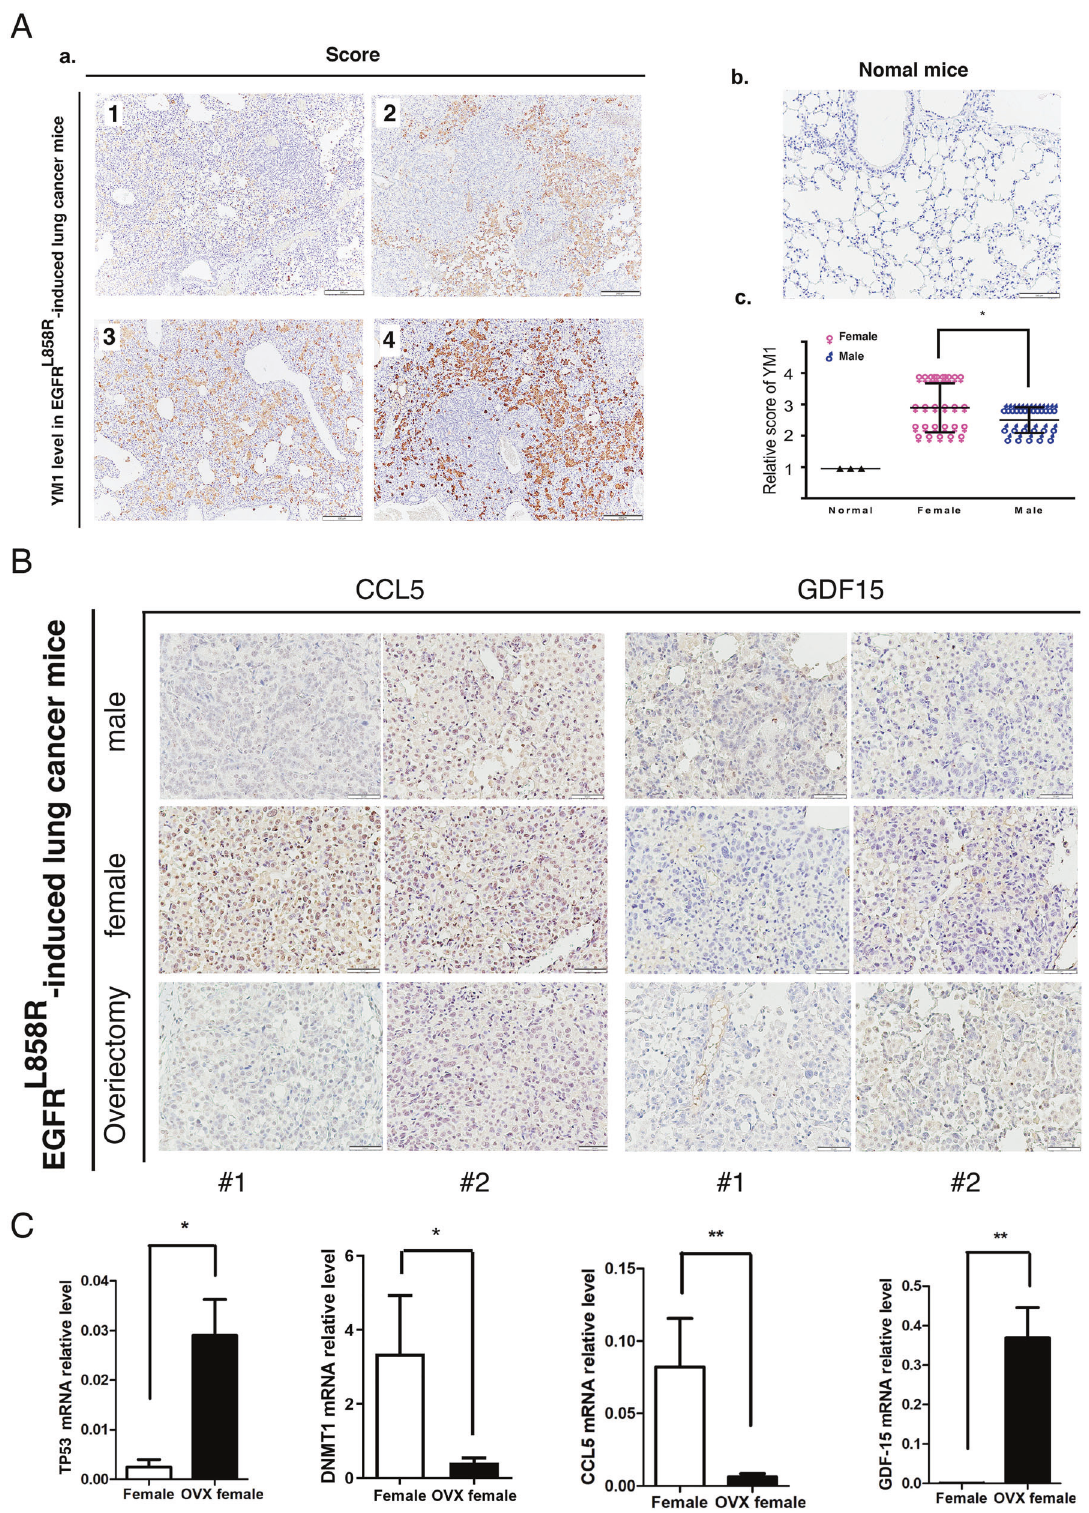
Fig. 7 The relationship among the protein levels of YM1, CCL5, and GDF15 and sex-dependent changes in lung cancer in EGFR L858R mice. The levels of YM1 were determined in EGFR L858R mice, and scored based on the YM1 image (score 1 to 4) ( A , a ) compared to normal mice ( A , b ). All the scores were calculated in normal mice and mice with EGFR L858R -induced lung cancer, including female and male mice ( A , c ). The levels of CCL5 and GDF15 in mice with EGFR L858R -induced lung cancer mice, including male and female mice with or without ovariectomy, were studied by IHC with antibodies against the indicated proteins ( B ). Total RNA was extracted from mice with EGFR L858R -induced lung cancer with or without ovariectomy, and then the mRNA levels of p53, DNMT1, CCL5, and GDF15 were studied by q-PCR ( C ). After three independent experiments were completed, the quantitation and statistical analysis were performed with a t tests; * P < 0.05, ** P <